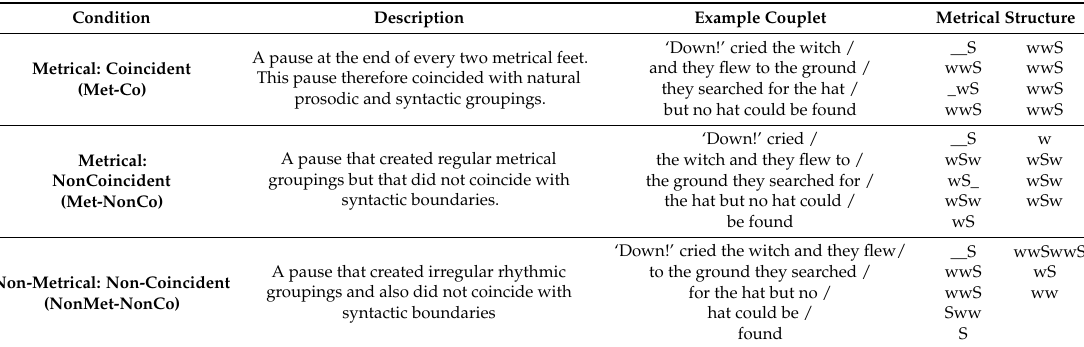
Table 2. Condition Characteristics with example